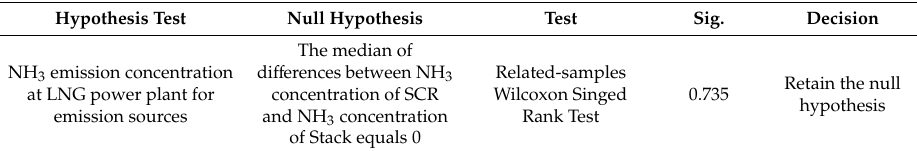
Table 3. The result of Wilcoxon Singed Rank Test by NH 3 concentration at LNG power plant for emission sources.